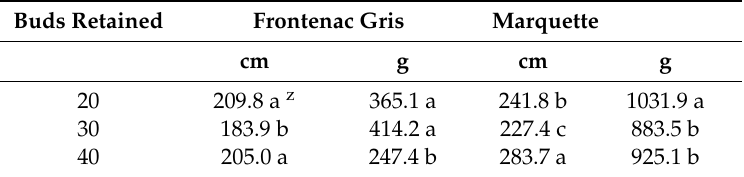
Table 4. Influence of bud retention on length of longest one-year-old cane and weight of pruned dormant canes for two V. riparia -based cultivars averaged over fruit-zone leaf removal levels, locations, and years. Buds